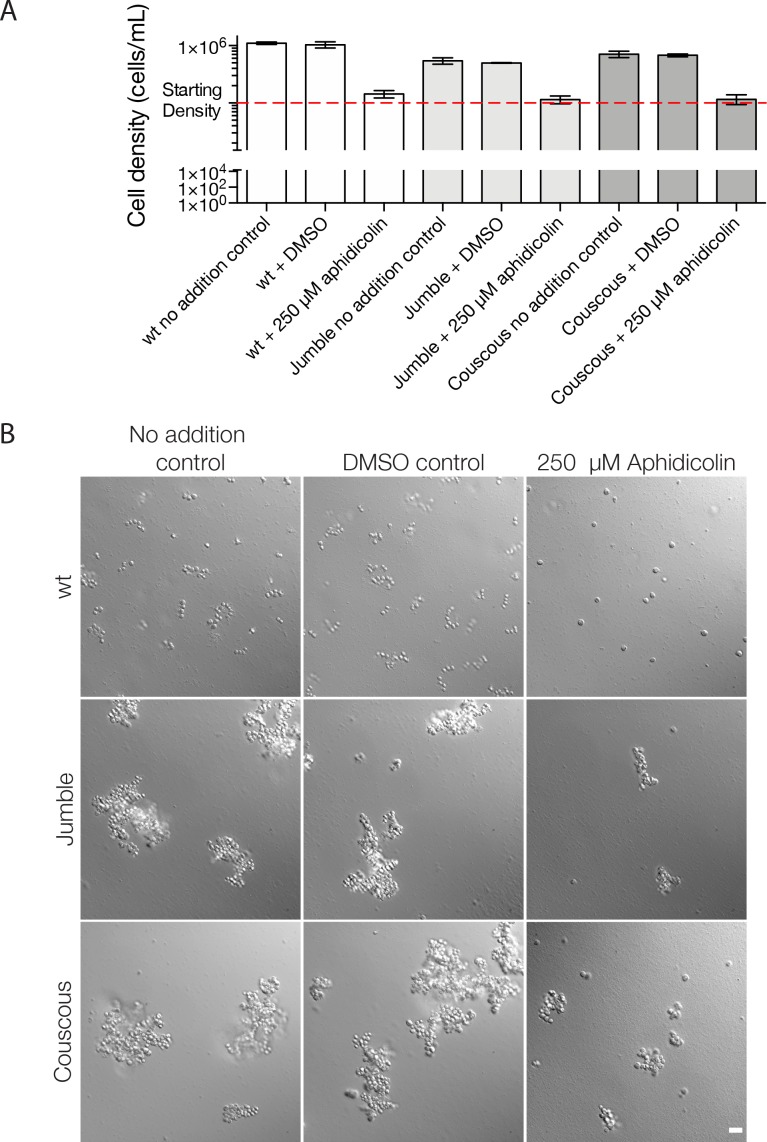
Cell division is not required for clump formation in mutants.Wild type, Jumble, and Couscous cells were vortexed and diluted to 1 × 105 cells/ml. Either no addition, DMSO, or 250 μM aphidicolin were added to wild type, Jumble, and Couscous. After 24 hr, cells were counted and imaged. (A) Aphidicolin successfully blocked cell division, while the no addition control and DMSO control grew for all conditions. Mean density plotted ±S.D for three technical replicates on the same day as imaged. (B) In wild type cells, no chains were observed in the aphidicolin-treated cells, but they were able to successfully grow chains when cultured either with no addition or only DMSO. For Jumble and Couscous, clumps formed in all conditions. Clumps formed in the presence of aphidicolin appear smaller, perhaps due to the lower cell density of the cultures or the lack of cell division, both of which may contribute to clump size. Scale bar = 20 μm.